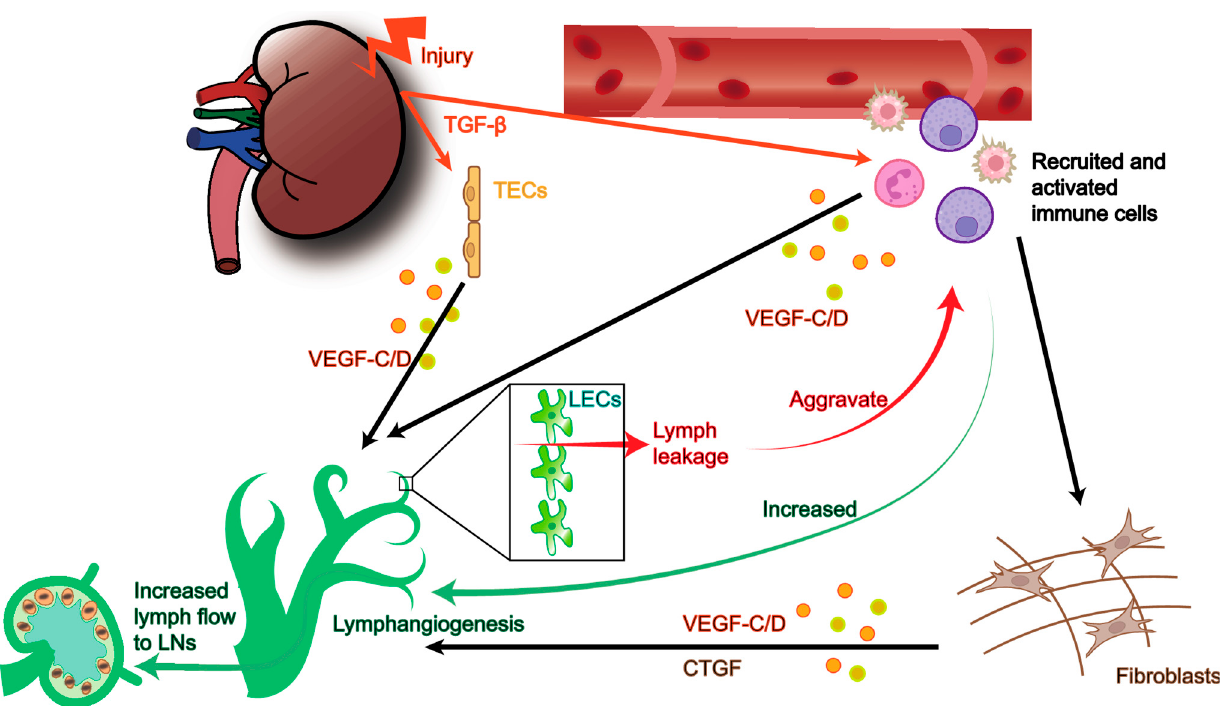
Figure 3. Lymphatic vascular proliferation in chronic kidney injury. In CKD, stimulated by TGF- β , TECs and activated immune cells (including macrophages, neutrophils, dendritic cells, and lymphocytes) are main sources of growth factors such as VEGF-C/D and CTGF, thereby promote lymphangiogenesis (black arrow). Expansion of the lymphatic network has a dual impact on CKD. The positive effect is that increased LVs promote the clearance from inflamed tissues (green arrow), while the negative influence is that hyperpermeability of injury-generated LVs may lead to lymph leakage and thus aggravate immune cytokines accumulation in kidney (red arrow). CKD: chronic kidney disease; CTGF: connective tissue growth factor; LEC: lymphatic endothelial cell; LN: lymph node; TEC: tubular epithelial cell; VEGF: vascular endothelial growth factor .